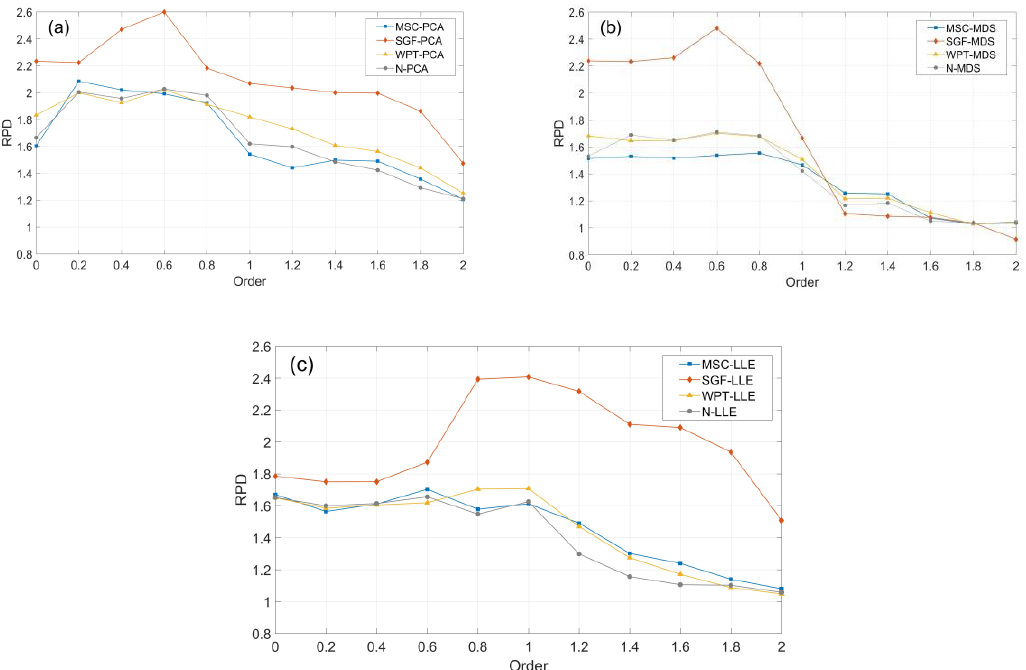
Figure 4. Line charts of RPD versus soil organic matter content estimation models using fractional derivatives in combination of ( a ) none (N) and principal component analysis (PCA), Svitzky–Golay filter (SGF) and PCA, multiplicative scatter correction (MSC) and PCA, wavelet packet transform (WPT) and PCA; ( b ) N and multidimensional scaling (MDS), SGF and MDS, MSC and MDS, WPT and MDS; ( c ) N and locally linear embedding (LLE), SGF and LLE, MSC and LLE, WPT and LLE.